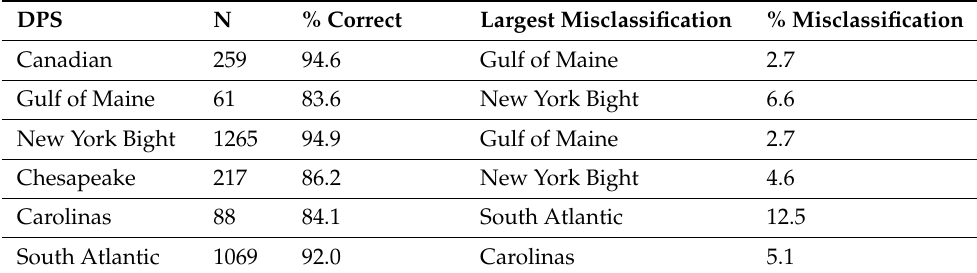
Table 5. Percentage of Atlantic sturgeon baseline reference individuals correctly assigned to the DPS in which they were collected and the DPS with the largest proportion of misclassification. These results are based on data from 11 microsatellite